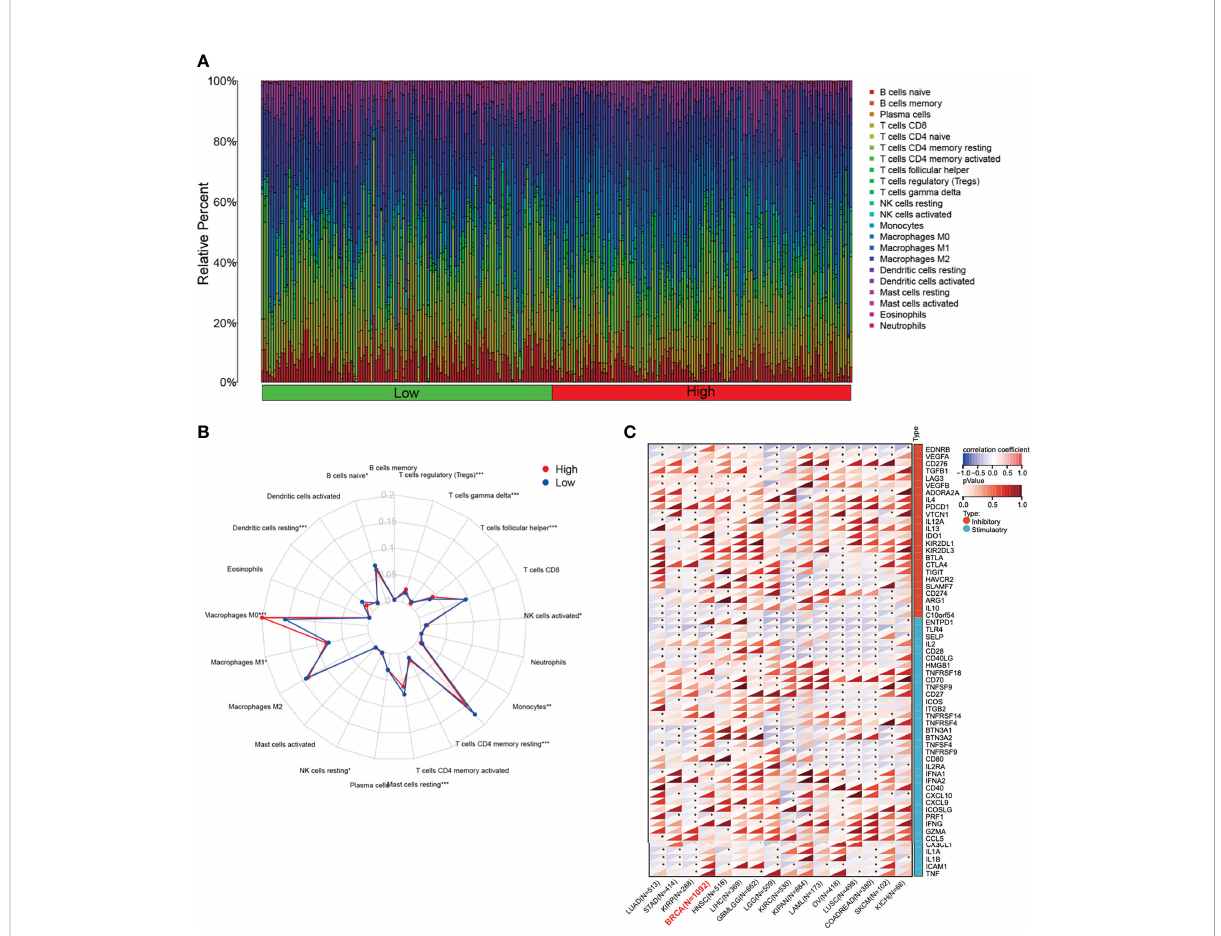
FIGURE 4 Correlation between the expression of PKMYT1 and immune in fi ltration. (A) The bar chart represented the component of immune cells in the high- and low-expressed PKMYT1 groups. (B) Comparison of different TME components between high and low PKMYT1 expression group. (C) Correlation between PKMYT1 and immune checkpoint mRNA level in various cancer type was analyzed in TCGA pan-cancer data. * p < 0.05, ** p < 0.01, *** p <